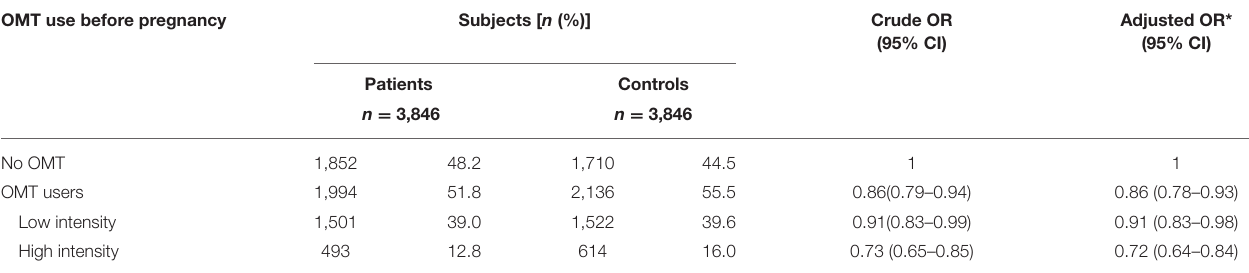
TABLE 2 | The association between LBP onset and use of OMT before pregnancy. OMT use before pregnancy Subjects [ n